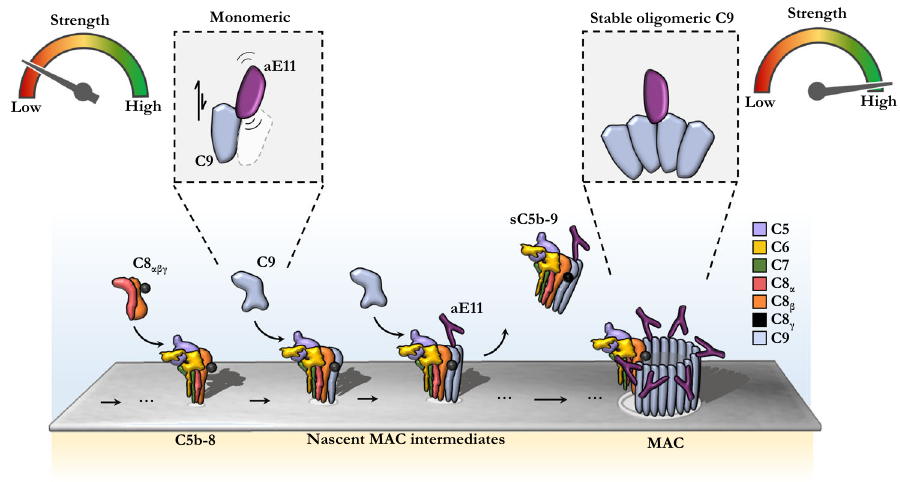
Fig. 5 Model of aE11 binding to monomeric and oligomeric C9. Illustration of aE11 recognition of the MAC. Under low concentration conditions little or no aE11 binding occurs. In addition, murine C9, which has a different aE11 binding interface to human C9, results in disruption of aE11 recognition. At high concentrations of monomeric C9, the partial neoepitope is weakly recognised by aE11. Stable formation of oligomeric C9 produces a long-lived, stable quaternary discontinuous epitope. Binding of aE11 to the oligomeric C9 component of the MAC is very